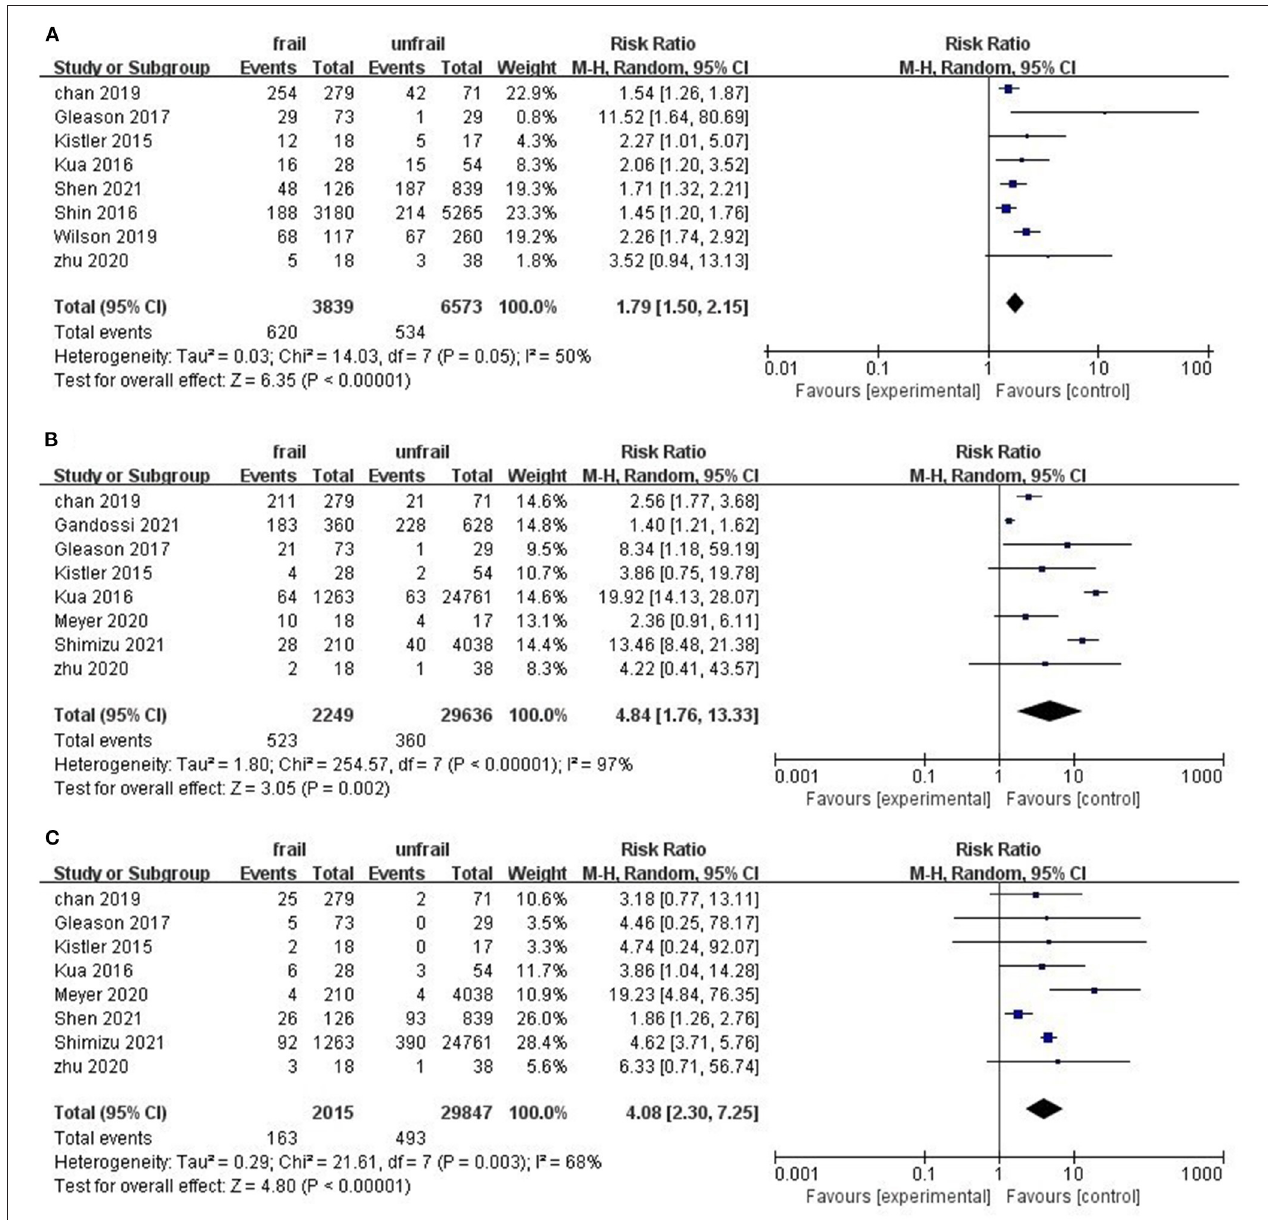
FIGURE 3 | Forest plots of frailty and postoperative complications of hip fractures. (A) Total complications (B) postoperative delirium (C)